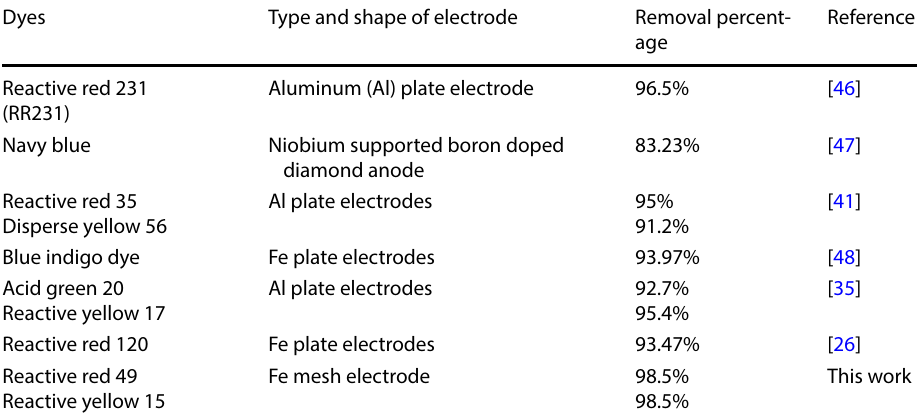
Table 6 Comparison of the proposed work with other publications of the same